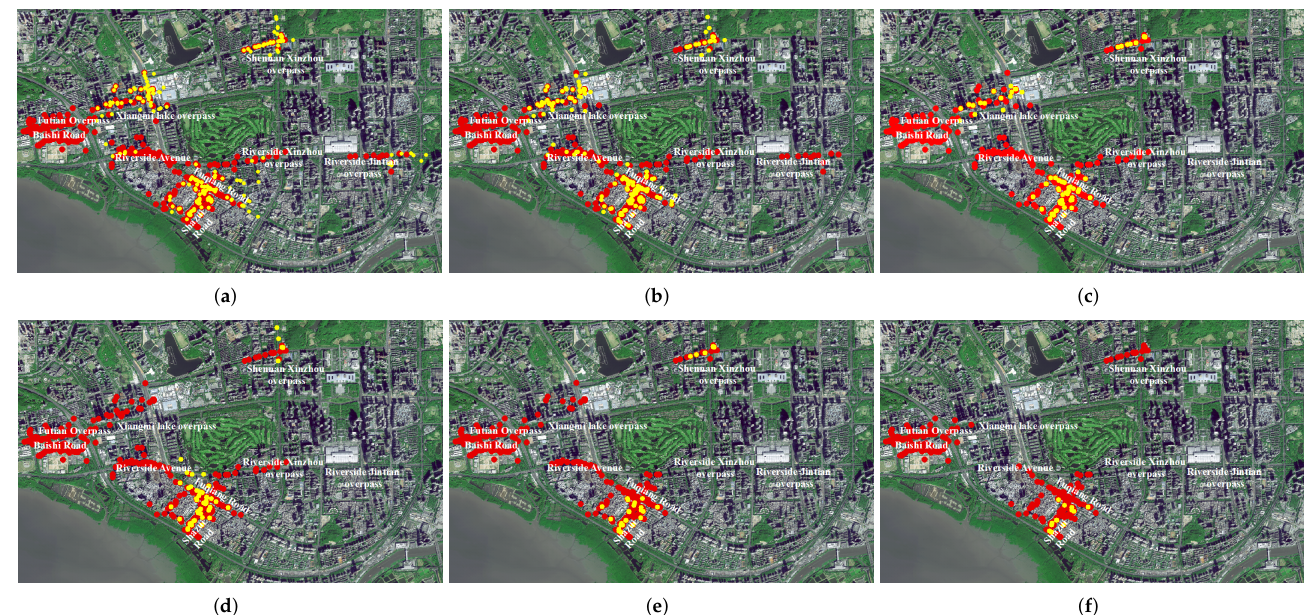
Figure 4. The LMCPs generated by Algorithm 1 (rendered by red) and swarms generated by CLUR (rendered by yellow). ( a ) λ = 3 and min o = 3; ( b ) λ = 4 and min o = 4; ( c ) λ = 5 and min o = 5; ( d ) λ = 6 and min o = 6; ( e ) λ = 7 and min o = 7; ( f ) λ = 8 and min o =